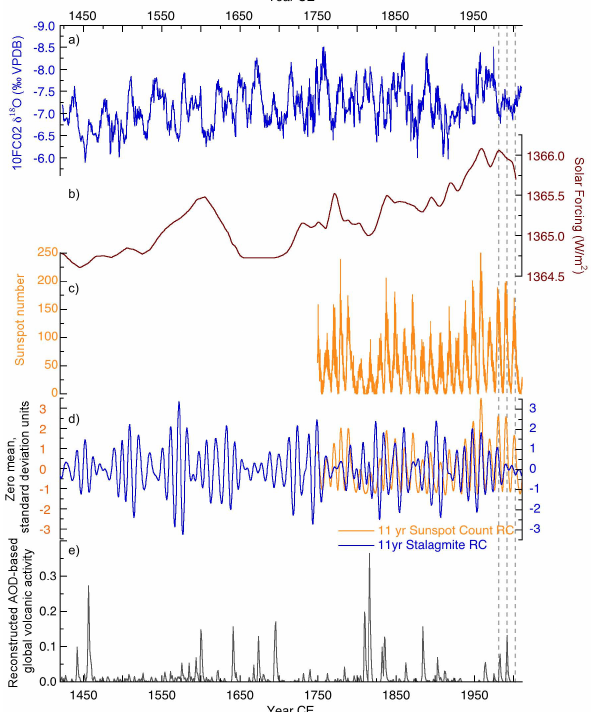
Figure 11. Stalagmite δ 18 O variations compared with records of so- lar and volcanic forcing over the period 1750–2009. (a) Stalagmite δ 18 O record. (b) Record of time evolution of solar forcing (Vieira et al, 2011). (c) Record of variations in sunspot number (Gray et al., 2010). (d) Reconstructed SSA components (RCs) in the stalagmite and sunspot number records, with 10 components and a 60-year window length, selected to highlight the 11-year sunspot cycle. For the stalagmite record, the fourth PC (8% variance at 12 years) and fifth PC (4% variance at 10 years), which average to 11 years, and account for 12% of the record variance, are used to create a stalag- mite RC. For the sunspot number record, the first PC (52% vari- ance at 12 years) and second PC (33% variance at 10 years), again averaging to 11 years, are used to create a sunspot RC. The most recent three peaks of sunspot activity used by Matthews (2011) and Meehl et al. (2009) to hypothesize a response in SPCZ precipitation to changing sunspot numbers are marked by vertical dashed lines. (e) illustrates the volcanic aerosol optical depth (AOD) proxy recon- struction of global volcanic activity from Crowley and Unterman (2012). There is no systematic relationship in phasing or amplitude modulation of the stalagmite record that supports external forcing by solar or volcanoes as a driver of multidecadal SPCZ variability.